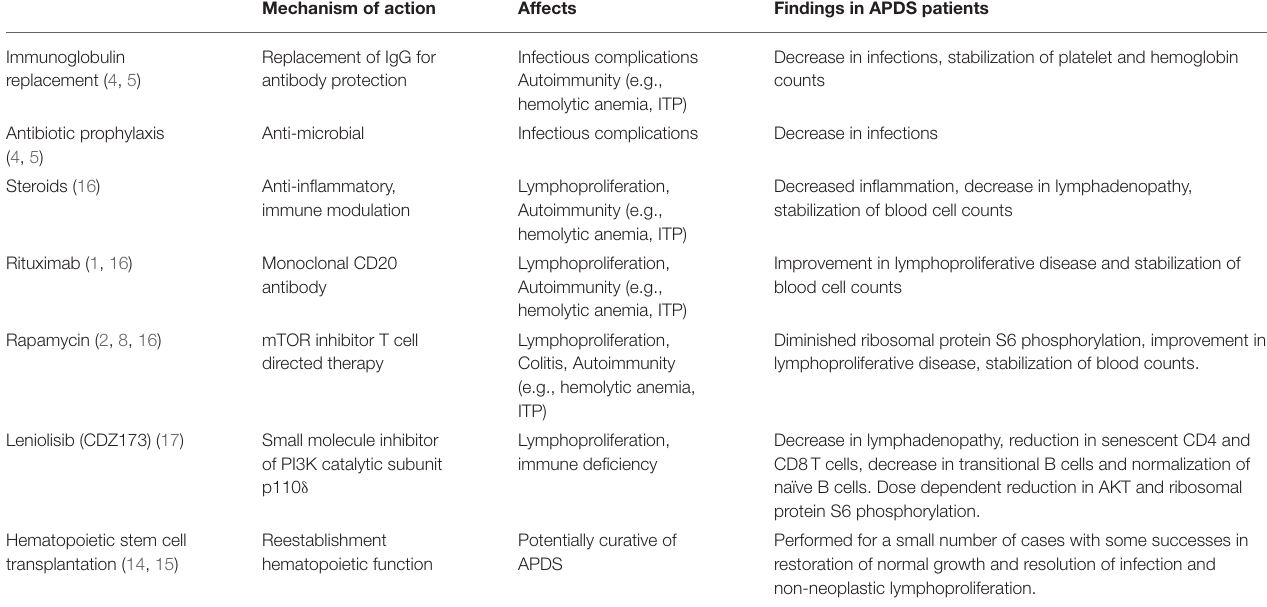
TABLE 2 | Therapies used in patients with APDS.